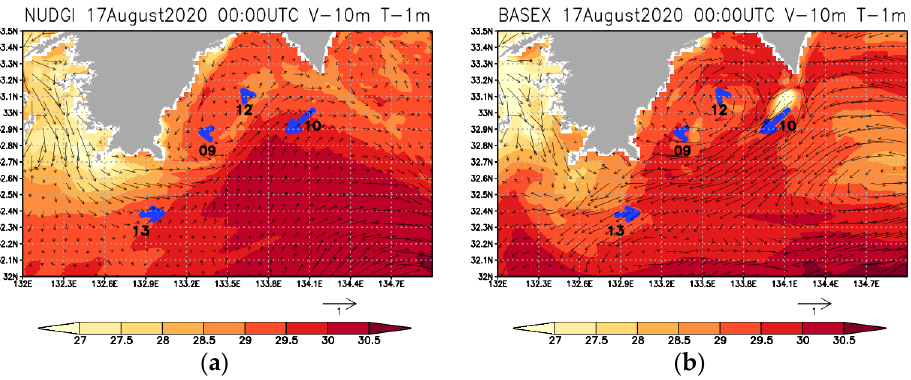
Figure 8. Snapshots of the modeled current at 10 m depth (black vectors) and temperature at 1 m depth (color) at 00 17 August 2020, UTC. ( a ) NUDGI case, ( b ) BASEX case. Blue vectors denote the current measured at the same time by four mooring buoys.